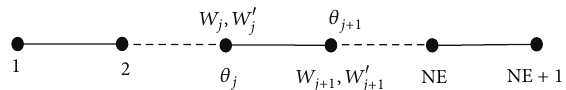
Figure 2: System discretized using elements with 3 degrees of freedom per